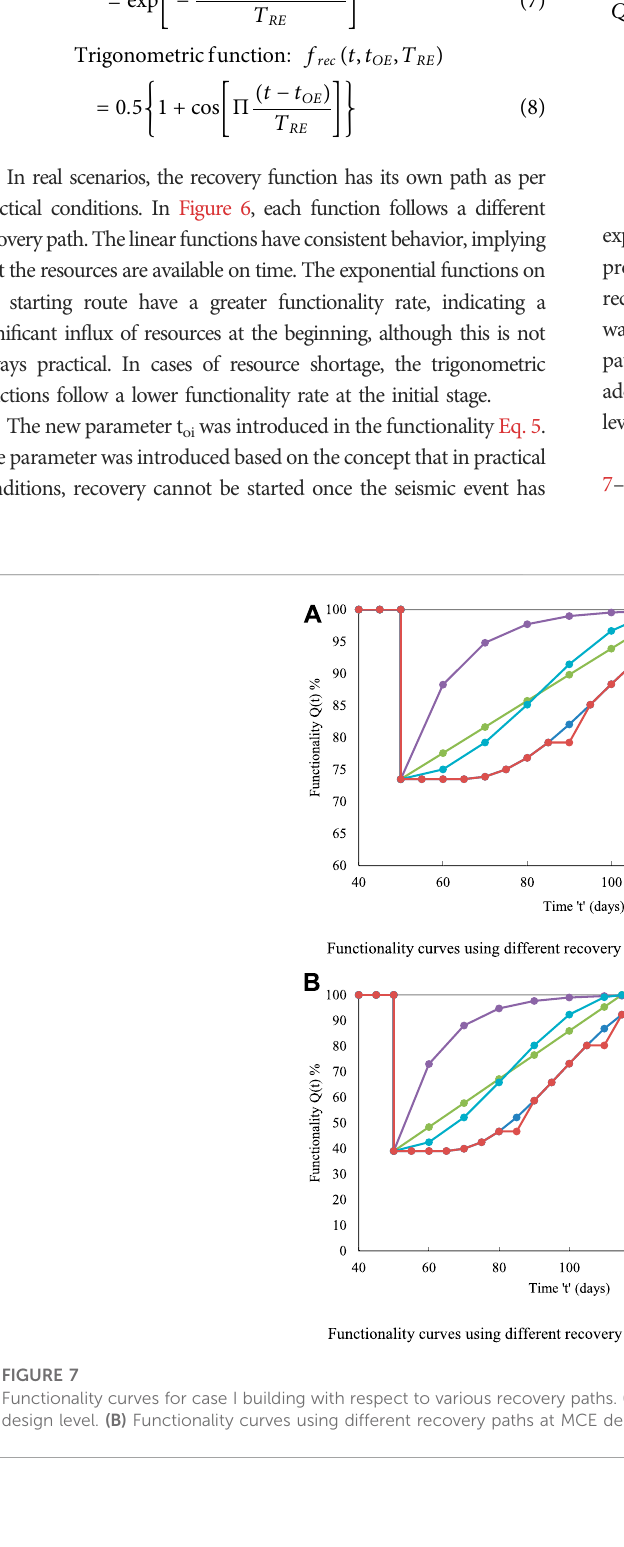
Frontiers in Built